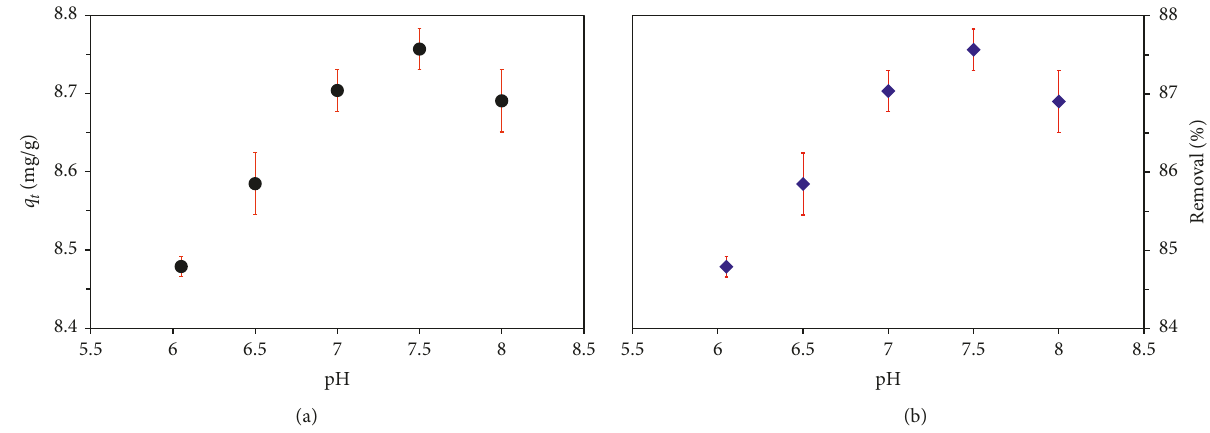
Figure 3: Influence of the solution pH on the NH 4+ adsorption capacity and removal efficiency of Al-waste-NaP1. Conditions: contact time 15min; adsorbent dose (cid:29)